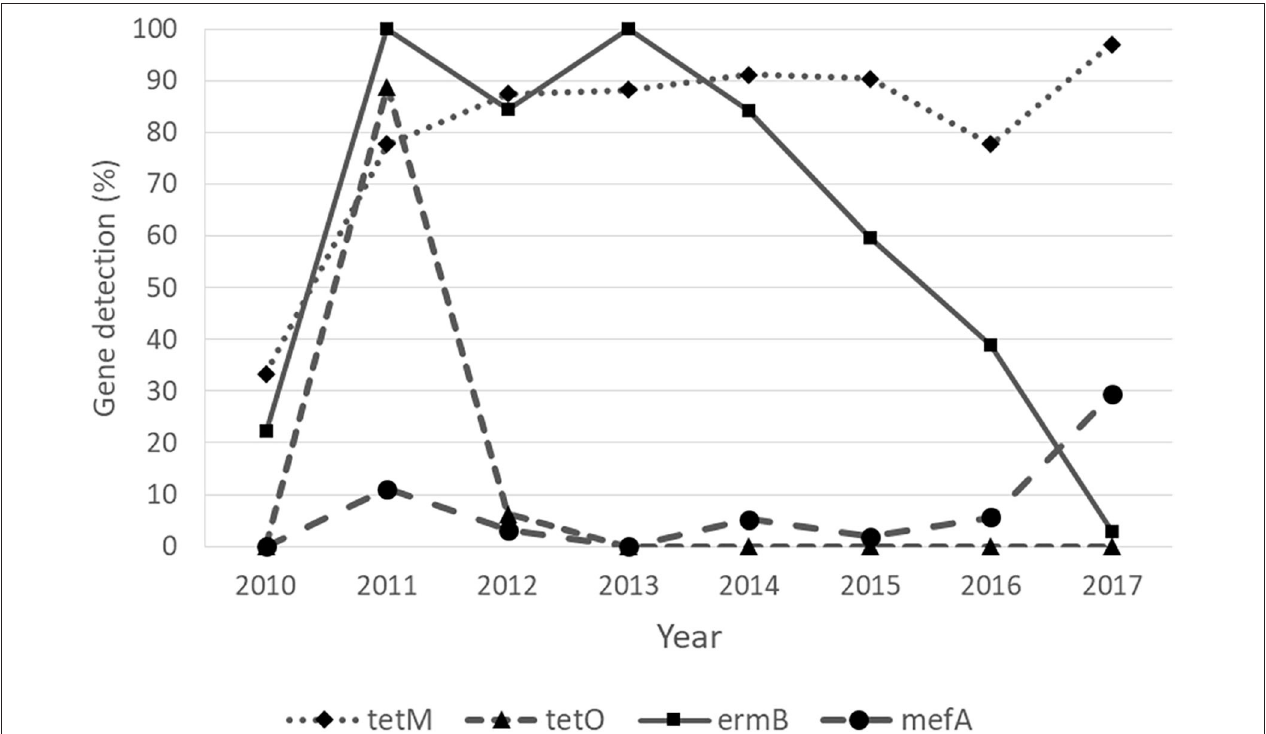
FIGURE 3 | Detection of antimicrobial resistance genes of Streptococcus uberis with “increasing” ( tetM and mefA ) and “decreasing” ( tetO and ermB ) trends over a period of 8 years, from 2010 to 2017.